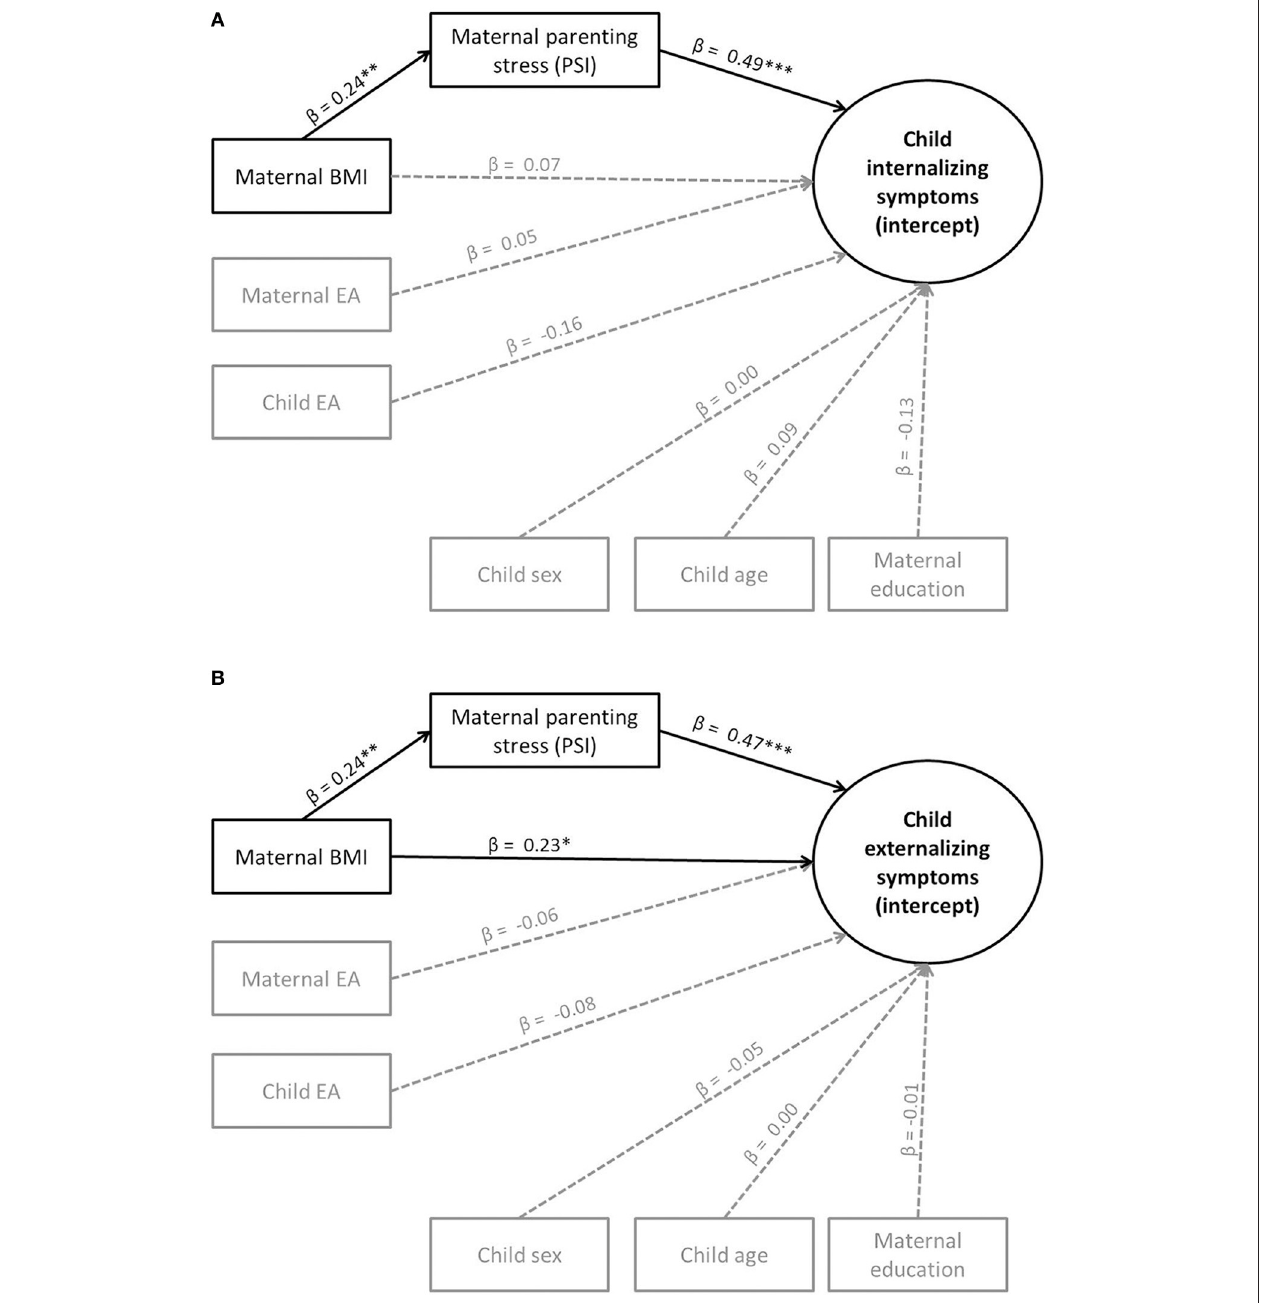
FIGURE 1 | (A) Mediation effects (standardized regression coefficients β ) on internalizing symptoms (Model 3). ** p < 0.01. *** p < 0.001. Model fit: χ 2 (183 , N = 194) = 297.58, p < 0.001, CFI = 0.85, RMSEA = 0.06. (B) Mediation effects (standardized regression coefficients β ) on externalizing symptoms (Model 3). * p < 0.05; ** p